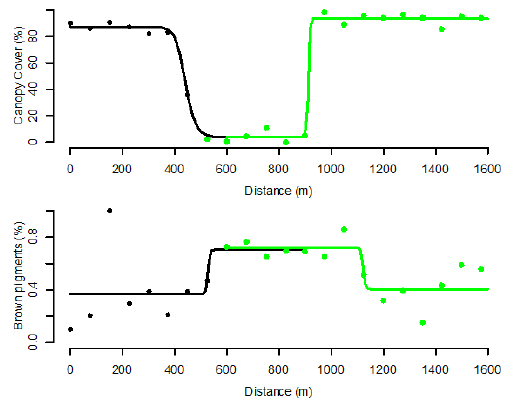
Figure 3. Selected models for canopy cover percentage (top panel) and brown pigments percentage in algae samples (bottom panel) throughout the 22 sampling sites along the forest-pasture-forest transitions in the Itaperiti stream (Rio de Janeiro, Brazil). Lines represent nonlinear fits for the upstream (Black) and downstream (Green)